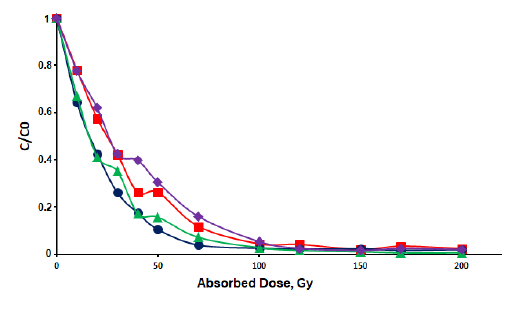
Figure 2. Efficiency of sertraline degradation and ionic products formation in aqueous solution saturated before irradiation with N 2 O- • OH radicals predominate: ( ● )-sertraline 1 mg/L degradation, ( ■ )-Cl − formation, ( )-NO 3 − formation, ( ♦ )-NO 2 − formation.